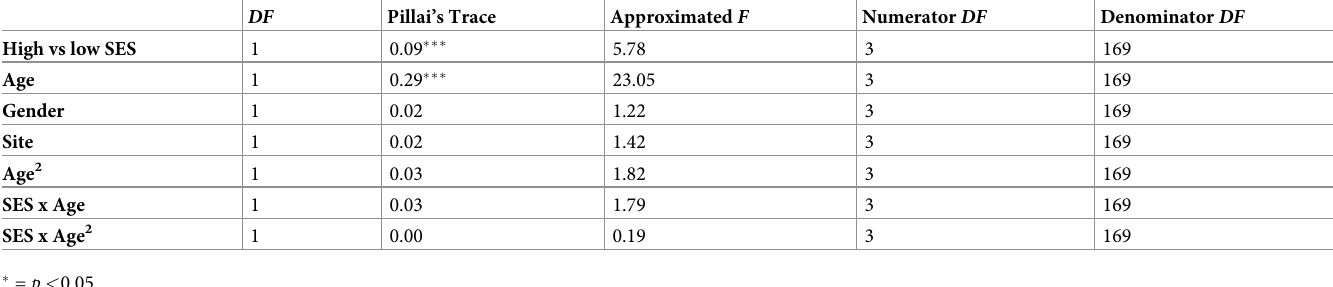
Table 5. MANCOVA of working memory measures as a function of low and high SES ( N = 185).